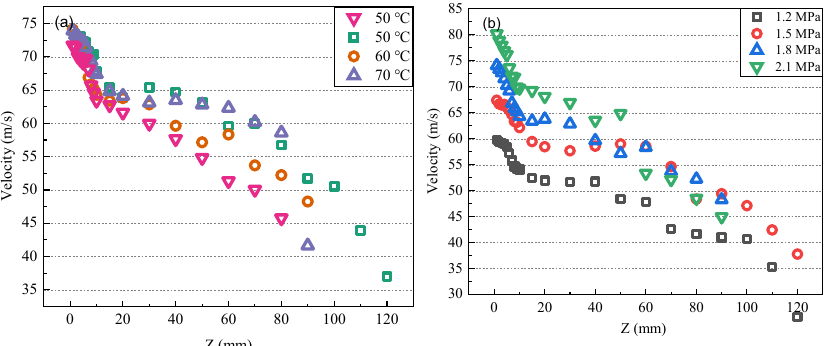
Figure 10. Effects of injection temperature and pressure on the variation of droplet velocity along spray’s central axis. ( a ) Effect of T inj on velocity variation under P inj = 1.5 MPa; ( b ) Effect of P inj on velocity variation under T inj = 60 °C.